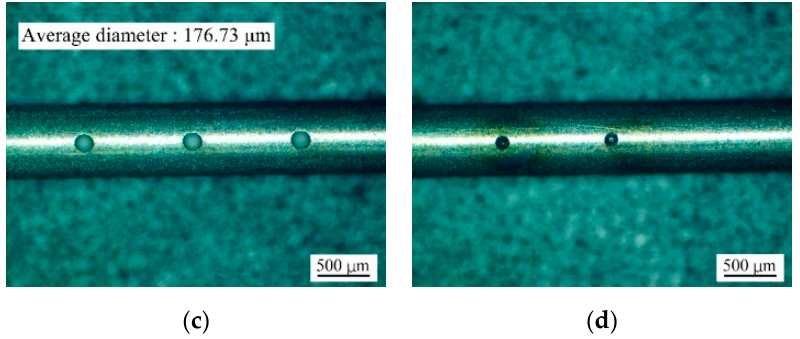
Figure 4. Shape of holes drilled with different duty cycles: ( a ) 50%; ( b ) 30%; ( c ) 20%; ( d ) 10%.